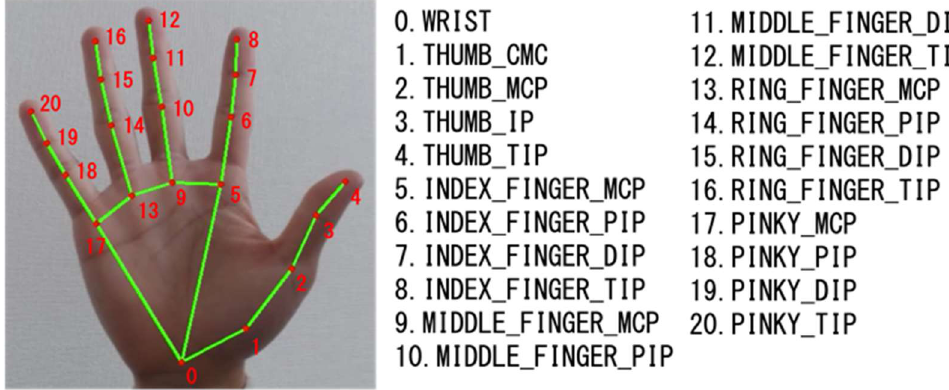
Figure 2. Example of skeleton coordinates by Mediapipe.